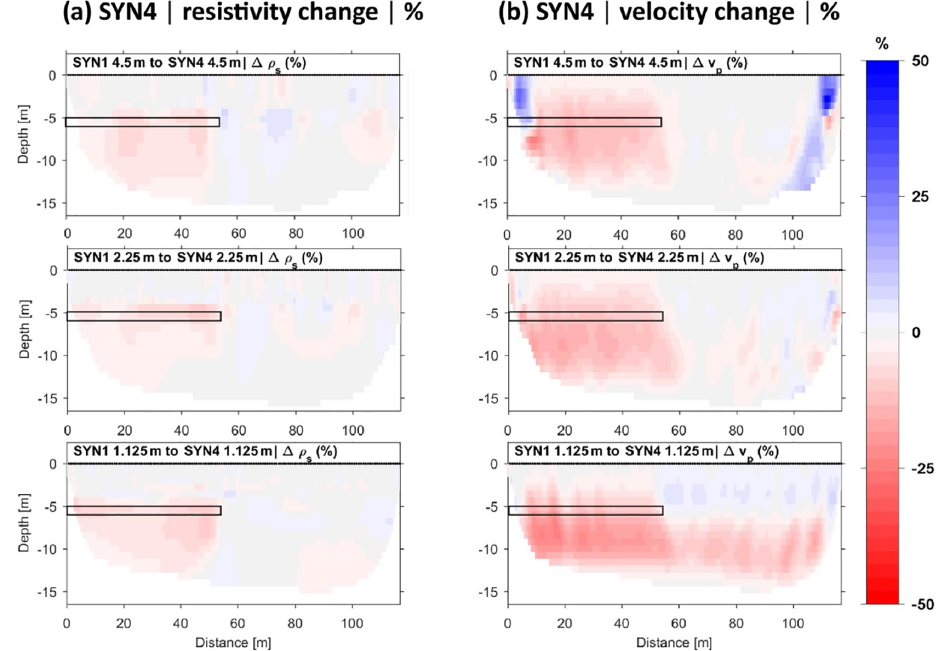
Figure 11. Comparison of (a) resistivity and (b) velocity changes of inverted tomograms for scenario SYN4 for three different sensor spacings. Top: 4.5m, middle: 2.25m, bottom: 1.125m. The position of the introduced change is indicated by black lines.